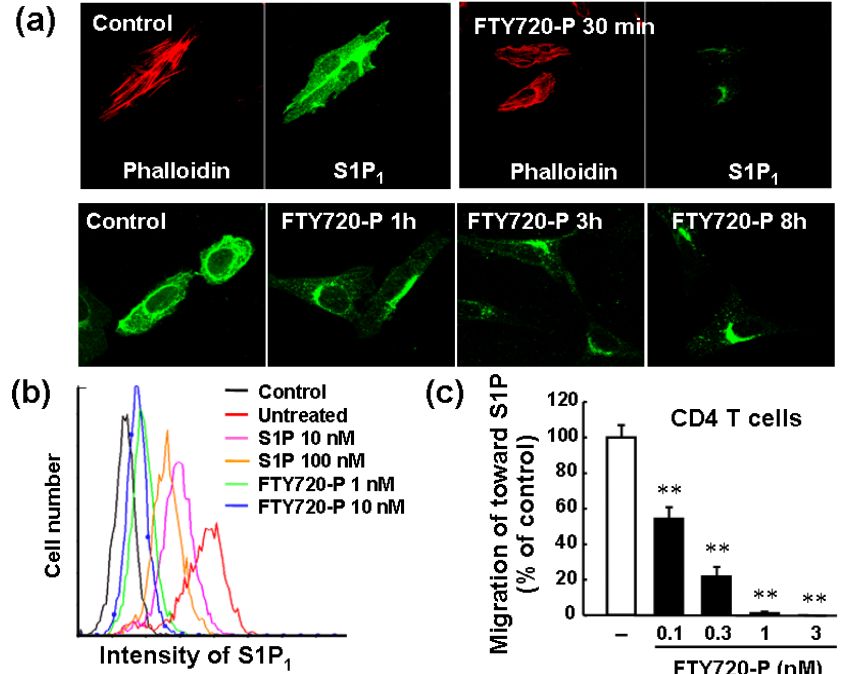
Figure 4. FTY720-P acts as a functional antagonist at lymphocytic S1P and inhibits 1 lymphocyte egress from the SLO [8,17,18,23]; ( a ) Confocal microscopy of human -expressing CHO cells treated with FTY720-P (100 nM) [8]; ( b ) Human S1P -expressing S1P 1 1 CHO cells were stained with FITC-conjugated anti-human S1P monoclonal antibody 1 (mAb) and expression of S1P on cell surface was analyzed by flow cytometry [17]; 1 ( c ) Pretreatment with FTY720-P inhibits migration of mouse CD4 T cells toward 10 nM -dependent lymphocyte S1P [18]; ( d ) FTY720-P converted from FTY720 inhibits S1P 1 egress from the SLO by internalization and degradation of lymphocytic S1P 1